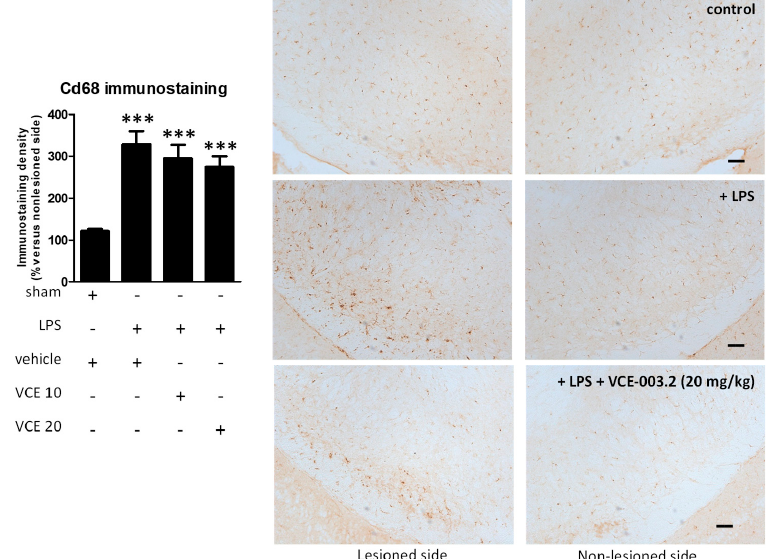
Figure 6. Intensity of the immunostaining for CD68 measured in a selected area of the substantia nigra pars compacta of control and LPS-lesioned mice orally treated for 28 days after lesion with vehicle (corn oil) or VCE-003.2 at the doses of 10 (VCE 10) or 20 (VCE 20) mg/kg. Immunoreactivity values are measured in the lesioned side over the non-lesioned side, and correspond to means ± SEM of more than 6 subjects per group. Data were assessed using the one-way analysis of variance followed by the Bonferroni test (*** p < 0.005 versus vehicle-treated control (sham) mice). Representative immunostaining images for sham and LPS-lesioned mice treated with vehicle or VCE-003.2 at 20 mg/kg are shown at right (scale bar = 200 µm).